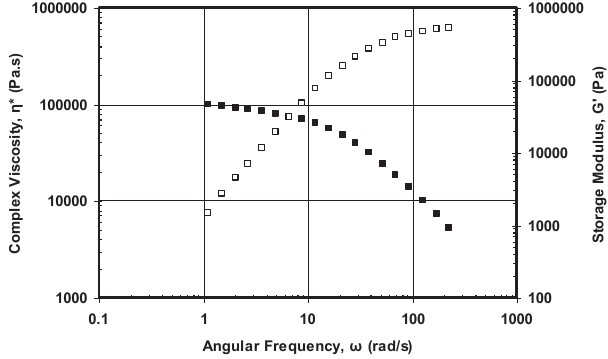
Fig. 5. Complex viscosity (η*) ( ) and storage modulus (G’) ( ) vs. angular frequency (ω) for conventional grade of PA 6 (Ultramid